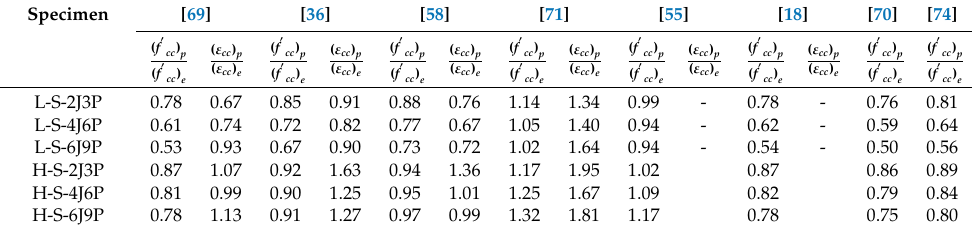
Table 12. Statistical performance of the strength model vs. experimental data of circular specimens.